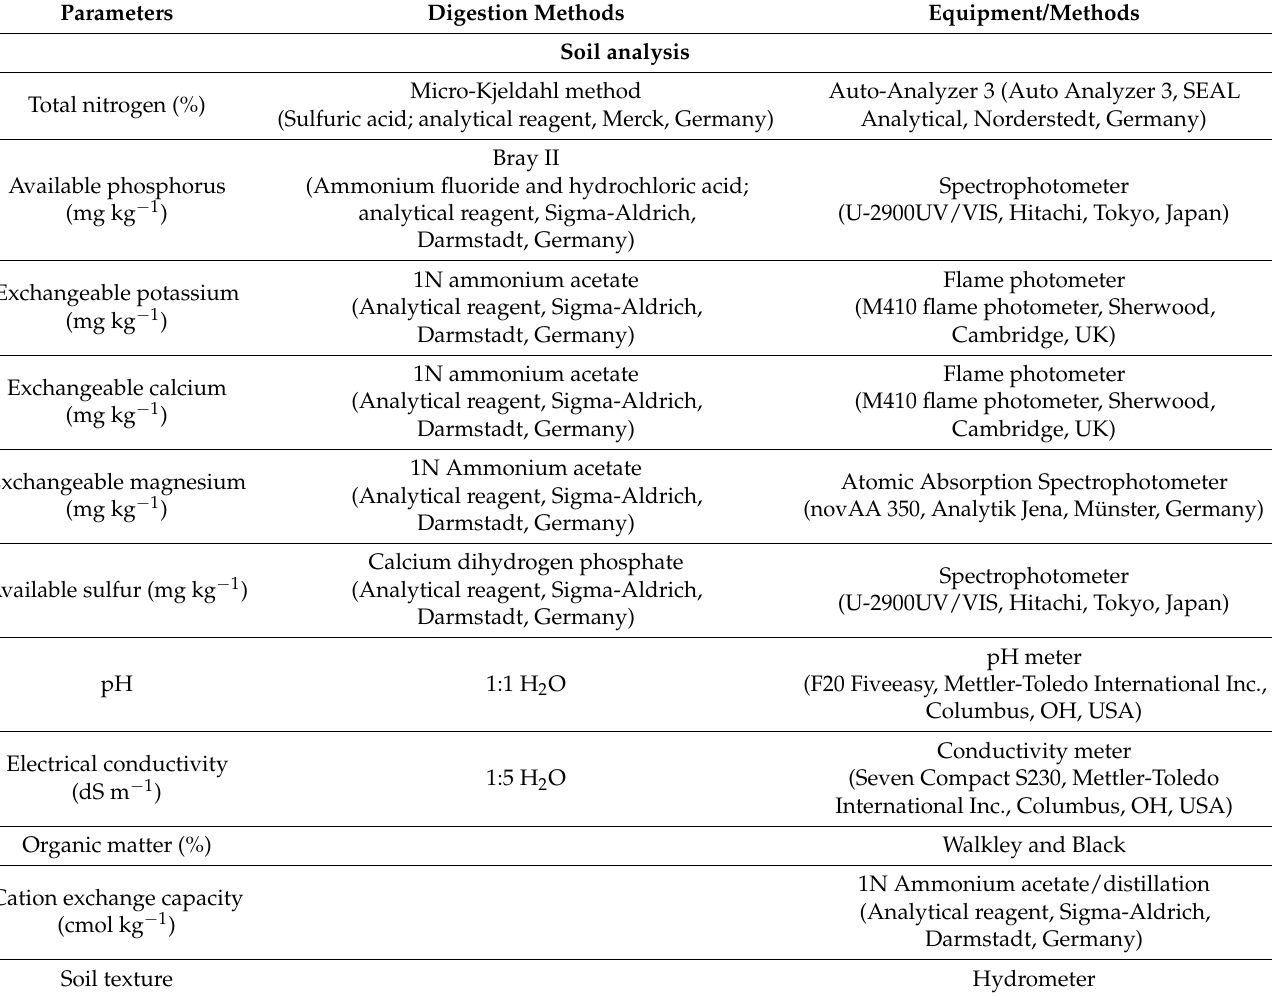
Table 1. The digestion methods and equipment used for soil physicochemical properties and plant nutrient determination in this